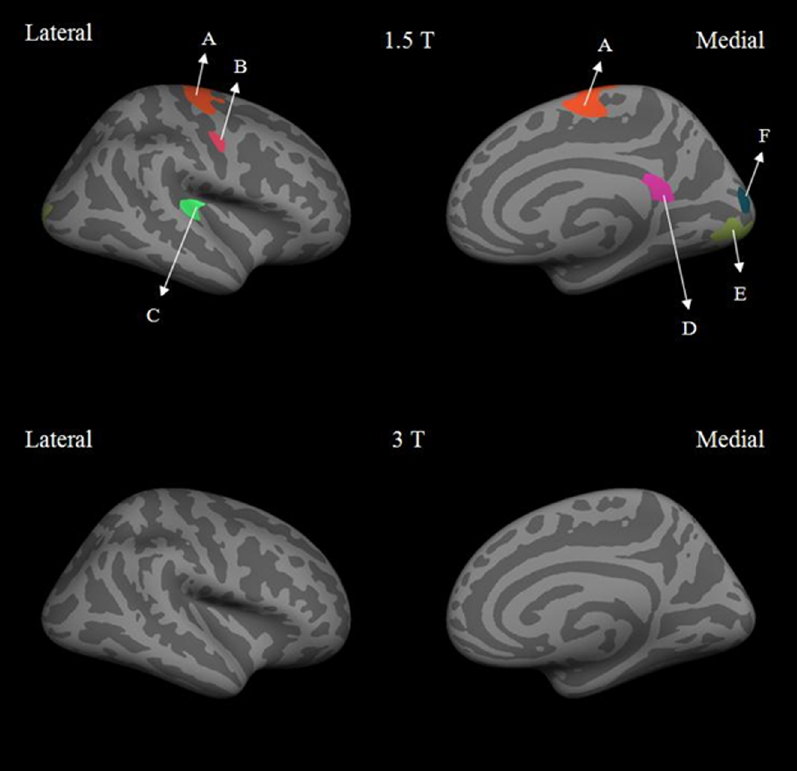
Figure 3. Lateral and medial views of inflated right hemisphere at 1.5 T and 3 T for male vs. female differences in cortical thickness. The labeled regions are: (A) and (B) precentral, (C) transverse temporal, (D) isthmus cingulate, (E) lingual and (F) cuneus vs. female cortical thickness difference maps at 1.5 T and 3 T for the left and right hemisphere respectively. At 1.5 T, the male vs.